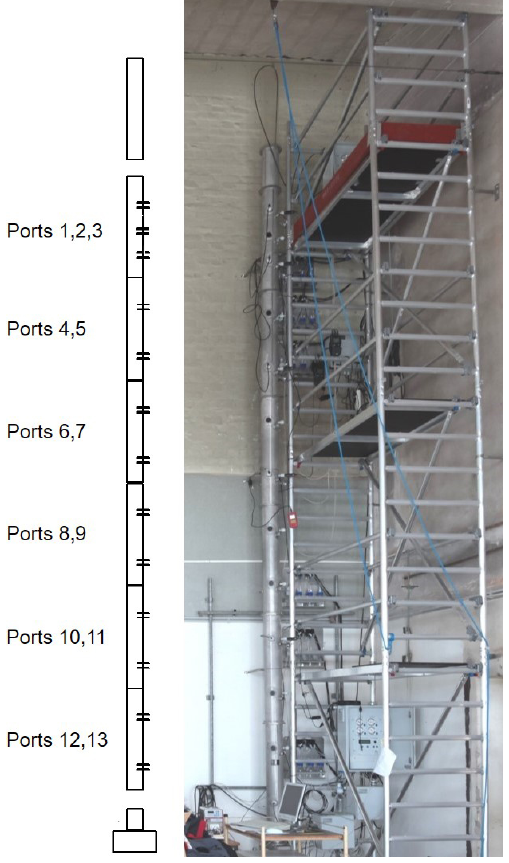
Figure 1. The 6m high column, Dresden, Germany. Sensors were located at ports 1, 3, 5, 7, 9 and